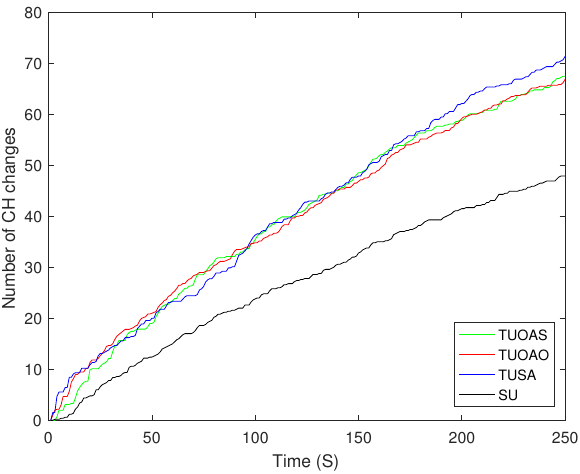
Figure 19. Number of CH